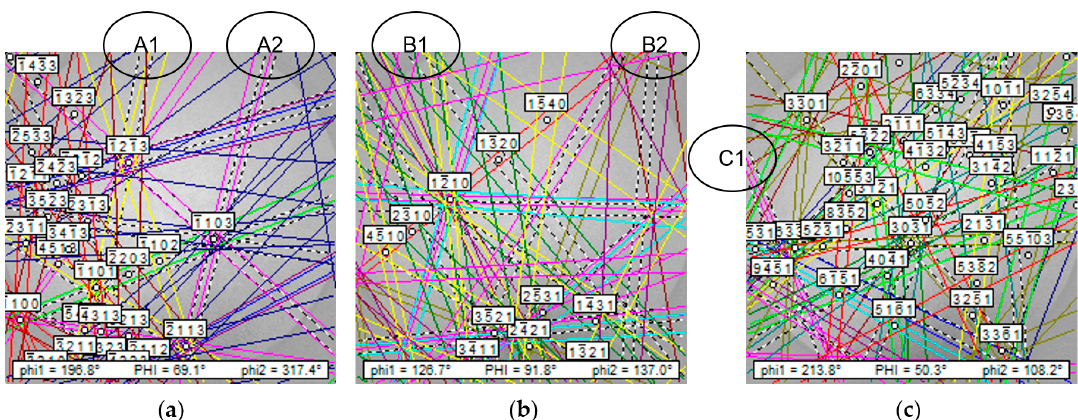
Figure 4. Comparison of original and computer-generated EBSD patterns from spots ( a ) A: LaNi 5 ; ( b ) B: Ce 2 Ni 7 ; and ( c ) C: Pr 2 Ni 7 of the 8-h annealed sample (Figure 2). Solid-color lines indicate the width of computer-generated band. Dashed-black lines show the width of actual band. A new band (B2) and bands with a slight rotation (A1), a shift (A2), a narrower width (B1), and a wider width (C1) are observed.